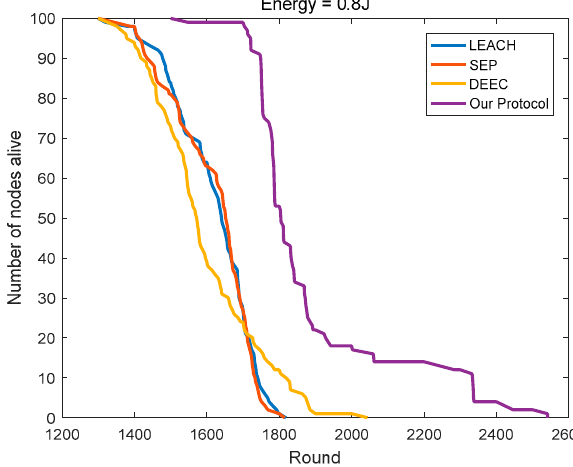
Sensors 2018 , 18 , x FOR PEER REVIEW Figure 15. The number of surviving nodes varies with the round (initial energy = 0.8 J).